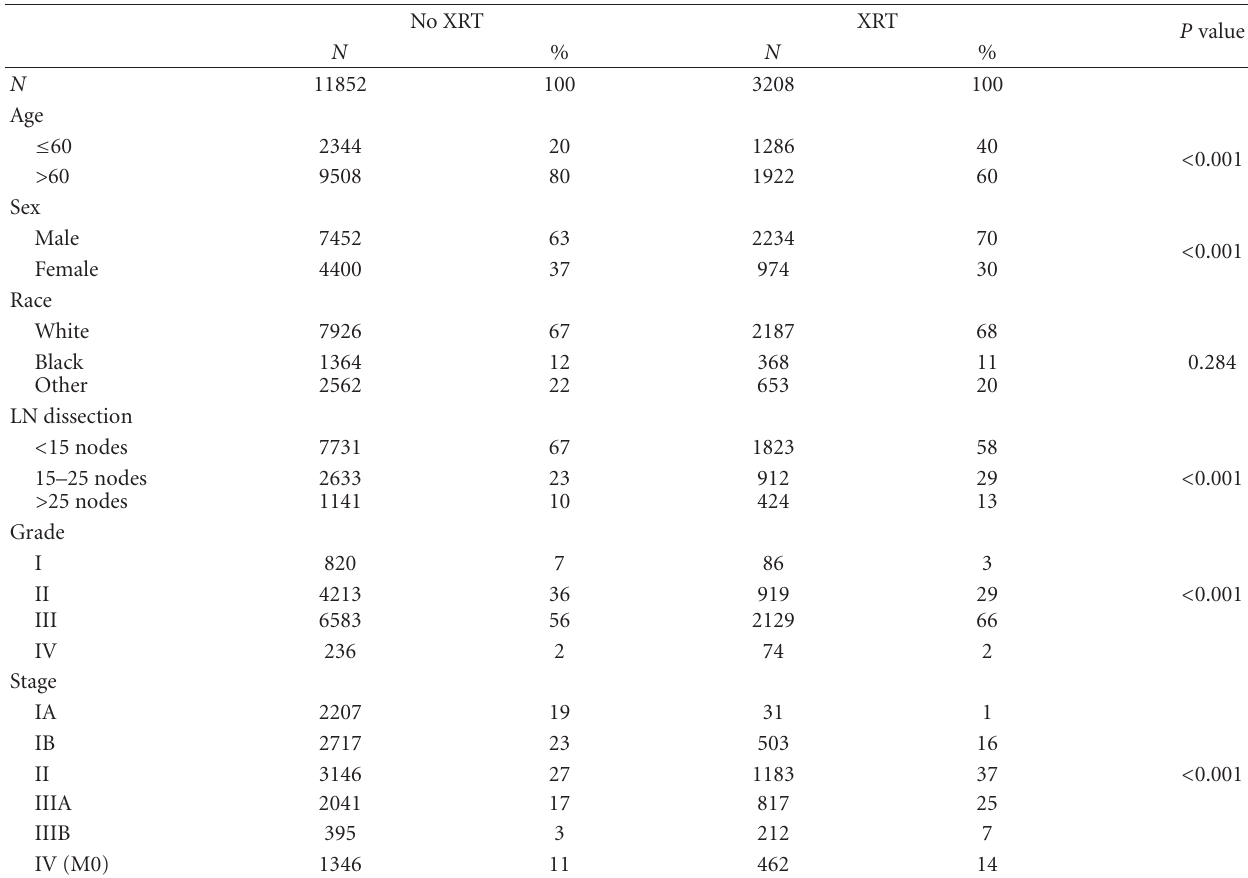
Table 1: Patient characteristics.